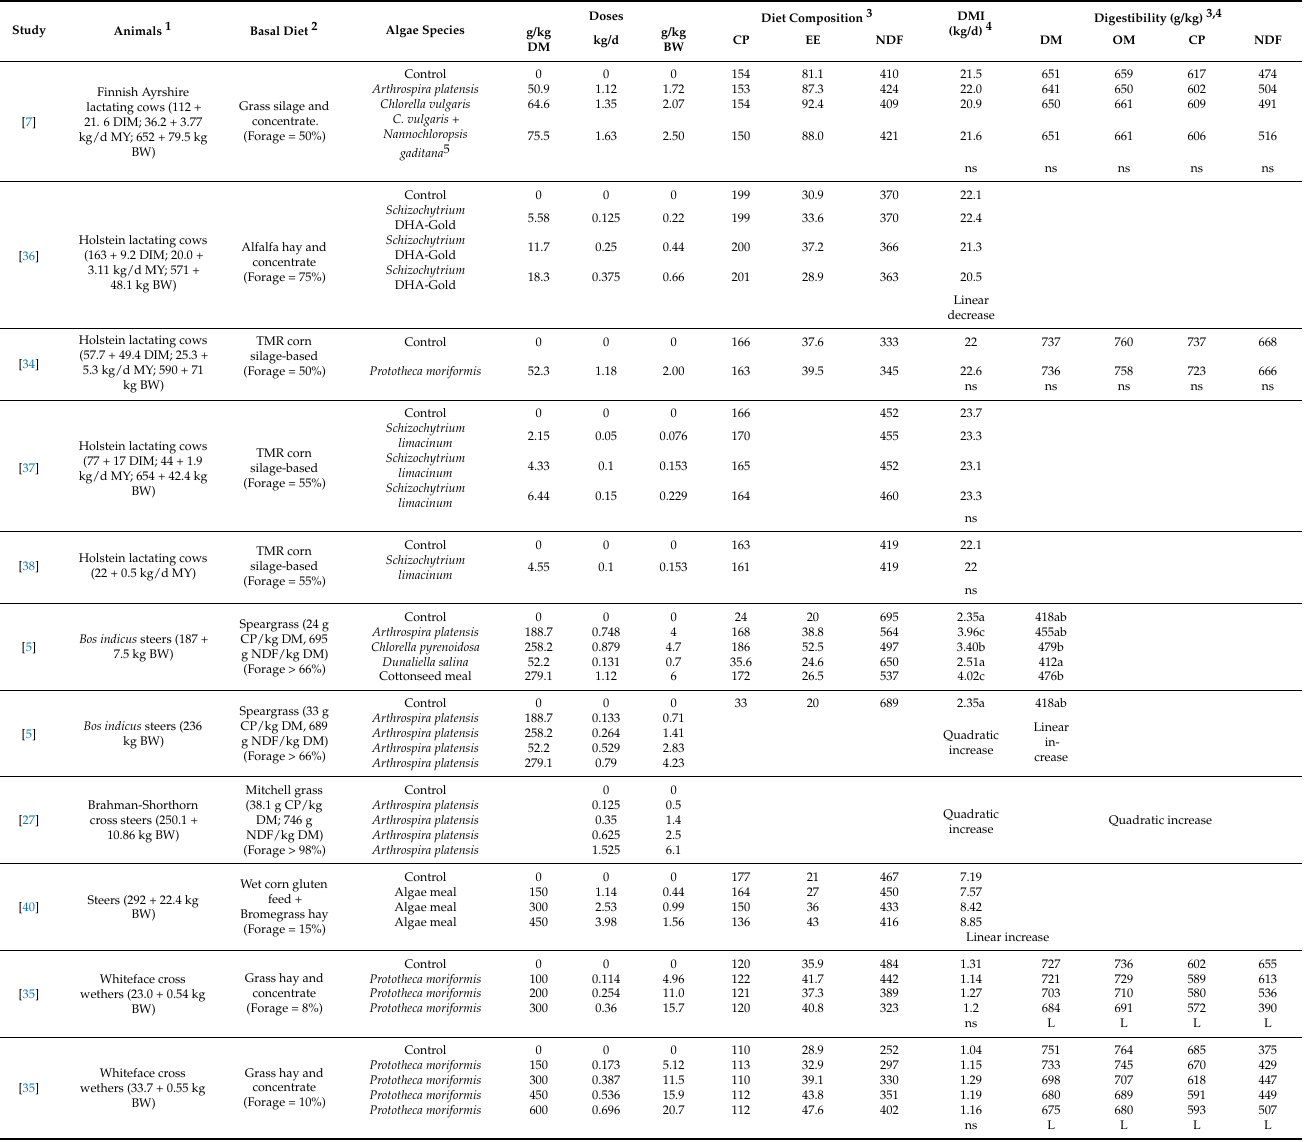
Table 2. Summary of in vivo studies testing the effects of algae on dry matter intake (kg/d) and apparent total tract digestibility (g/kg) in